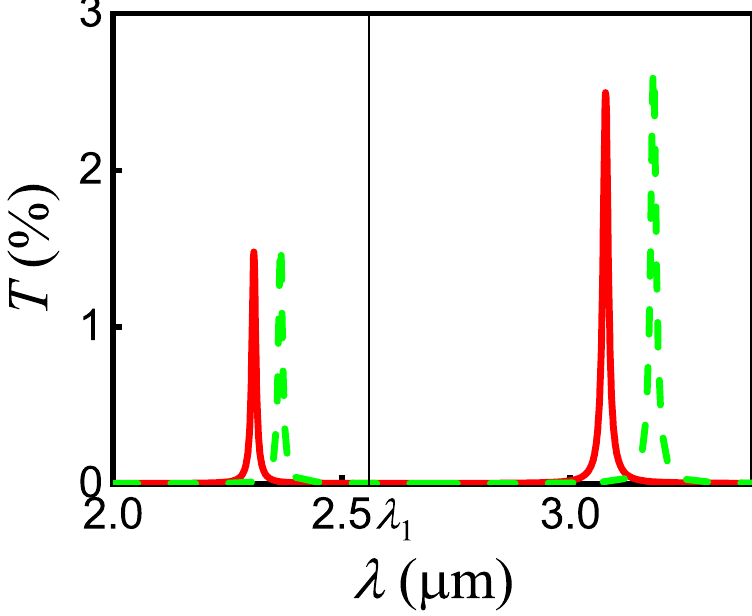
Figure 13. The pump SPP transmittance for the stub nanoresonator in the vicinity of λ 1 in the absence (solid red line) and in the presence (dashed green line) of signal